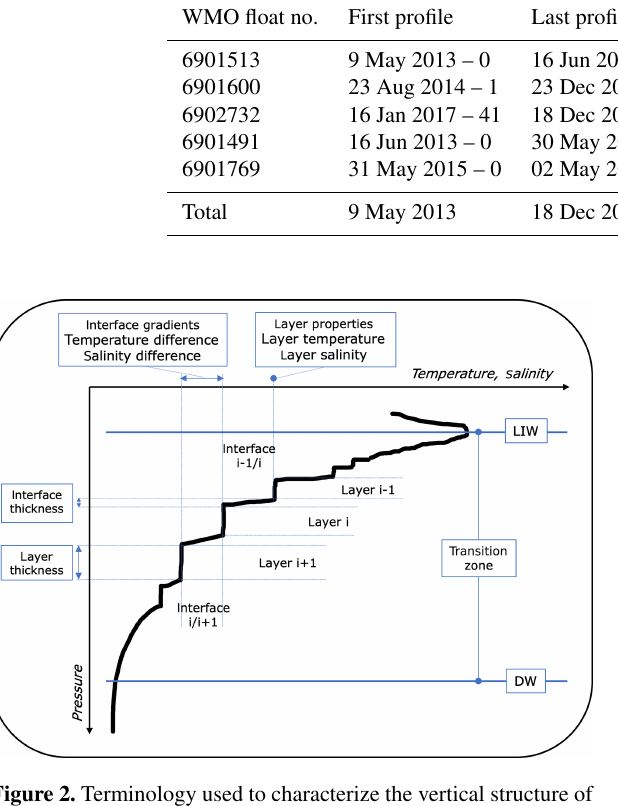
Figure 2. Terminology used to characterize the vertical structure of typical thermohaline staircases in the study area. The layer number ( i ) and the interface number ( i / i + 1) increase